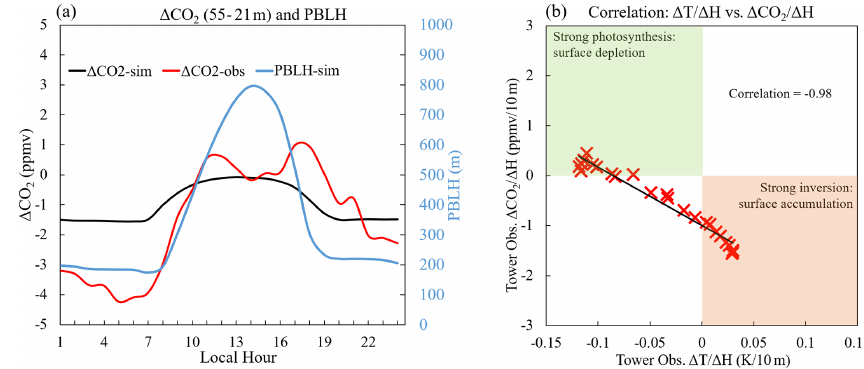
Figure 8. (a) Average (2016–2018) diurnal variations of simulated (black line) and observed (red line) (cid:49) CO 2 and simulated (blue line) PBLH at Lin’an station and (b) correlation between CO 2 gradient between 55 and 21m ( (cid:49) CO 2 /(cid:49)H ) and temperature gradient ( (cid:49)T/(cid:49)H ) at Lin’an